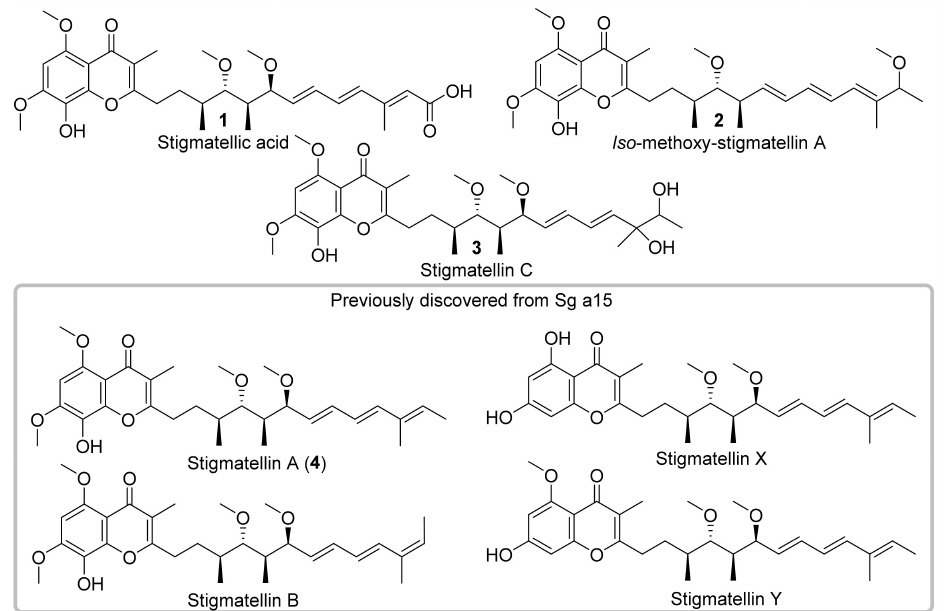
Figure 1. Chemical structures of new stigmatellin derivatives stigmatellic acid ( 1 ), iso -methoxy- stigmatellin A ( 2 ) and stigmatellin C ( 3 ) isolated from the myxobacterium Vitiosangium cumulatum MCy10943 T . In contrast to the previously isolated stigmatellin A ( 4 ) and B (in grey box), these new derivatives show significant differences in the side chains underlining important biosynthetic steps during the biosynthesis of the